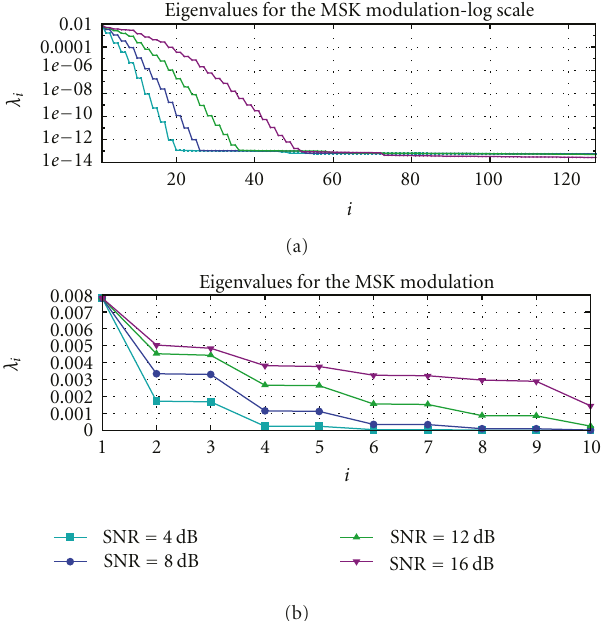
Figure 6: Eigenvalues for the MSK model with di ff erent values of